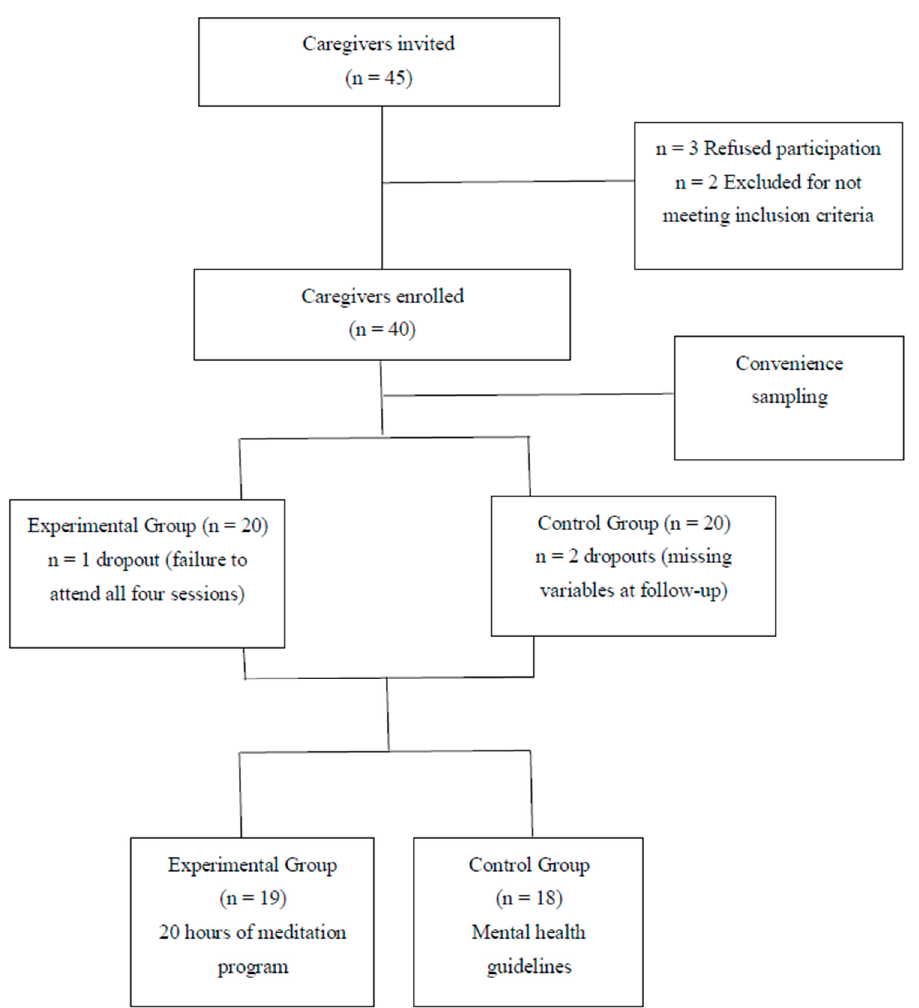
Figure 1. Flow of participants.